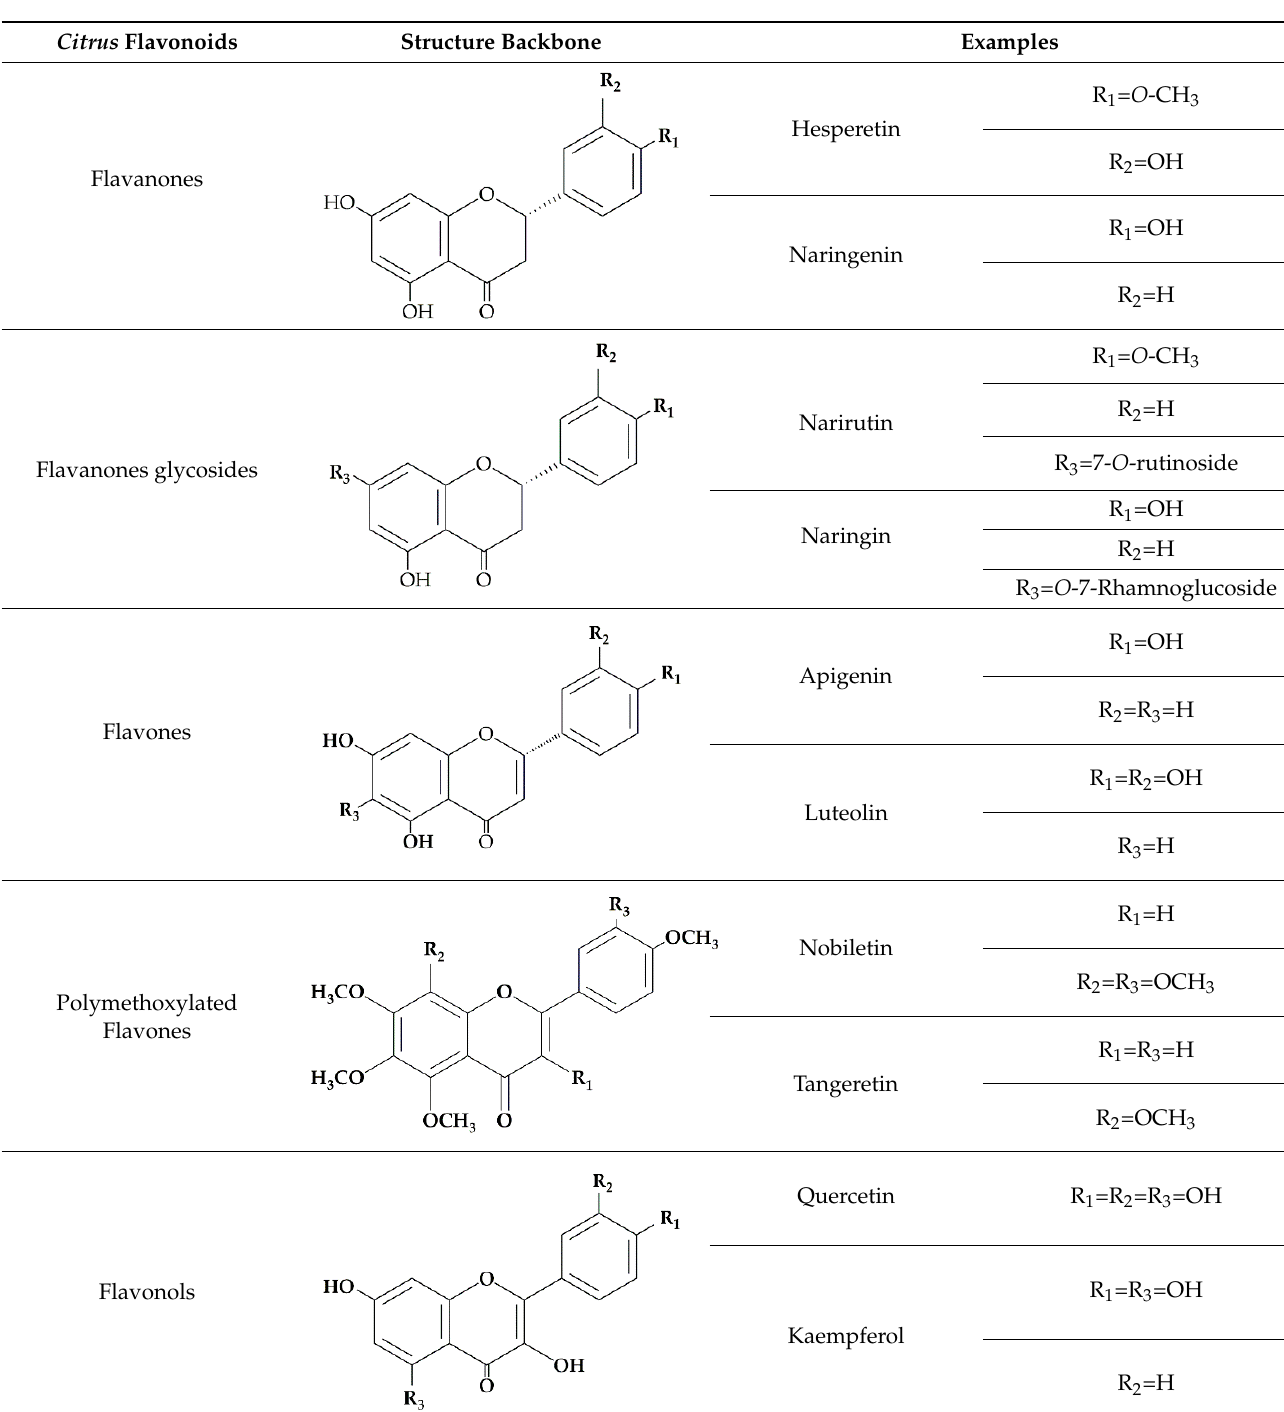
Table 2. Basic structures of Citrus flavonoid subclasses [16].